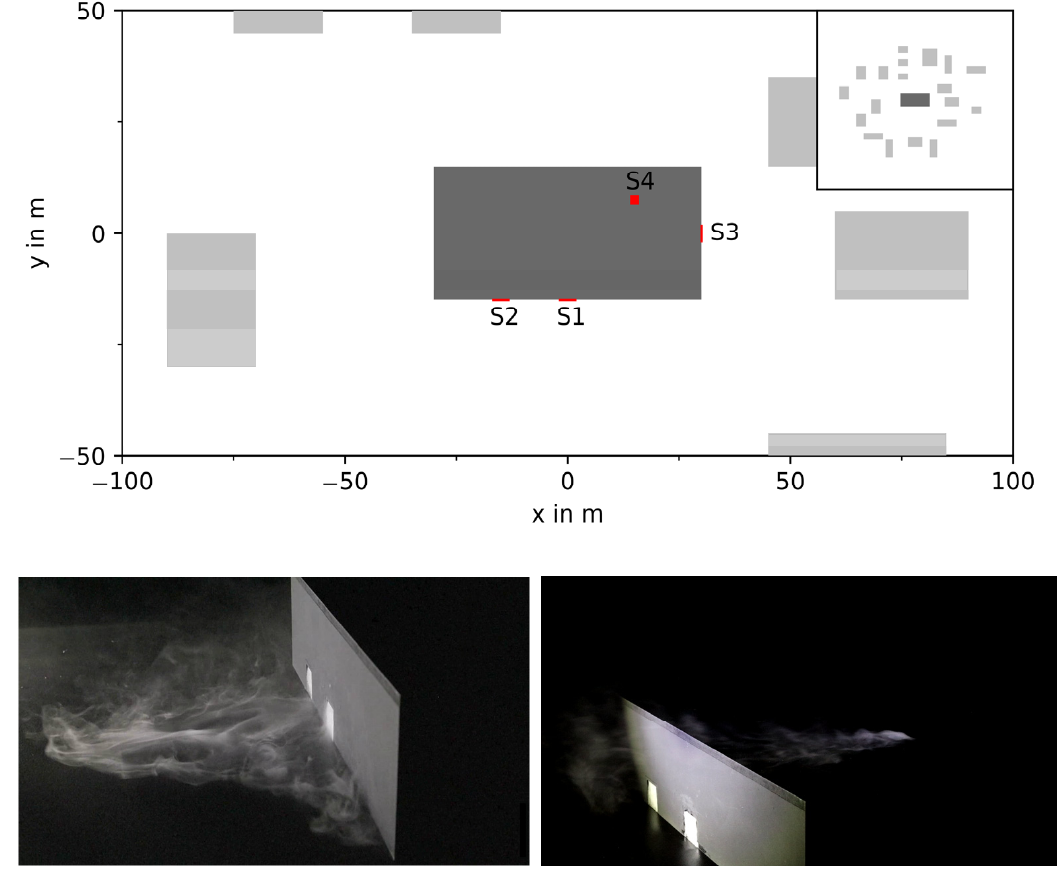
Figure 3. Source locations in the wind tunnel model. Top: schematic view of all source locations, Bottom left: S1 and S2 with haze visualization, Bottom right: S4 with haze visualization.